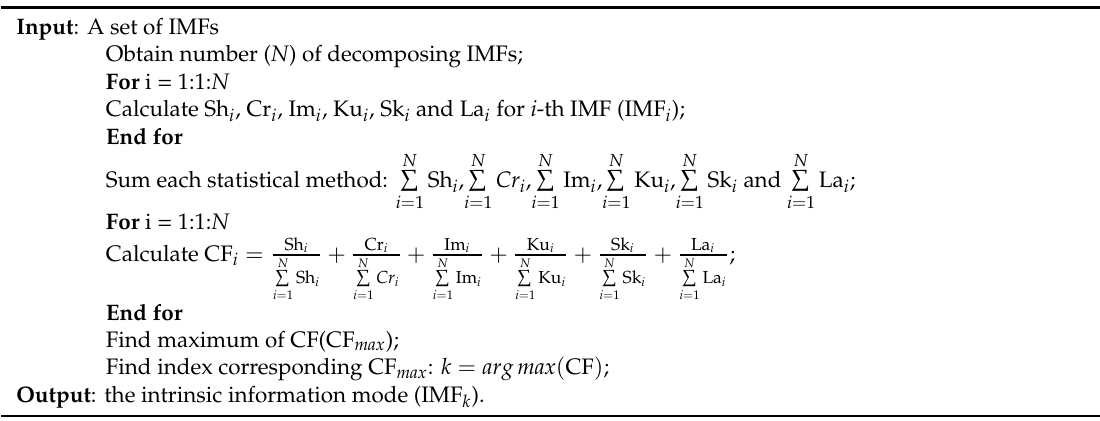
Table 5. Framework of identified